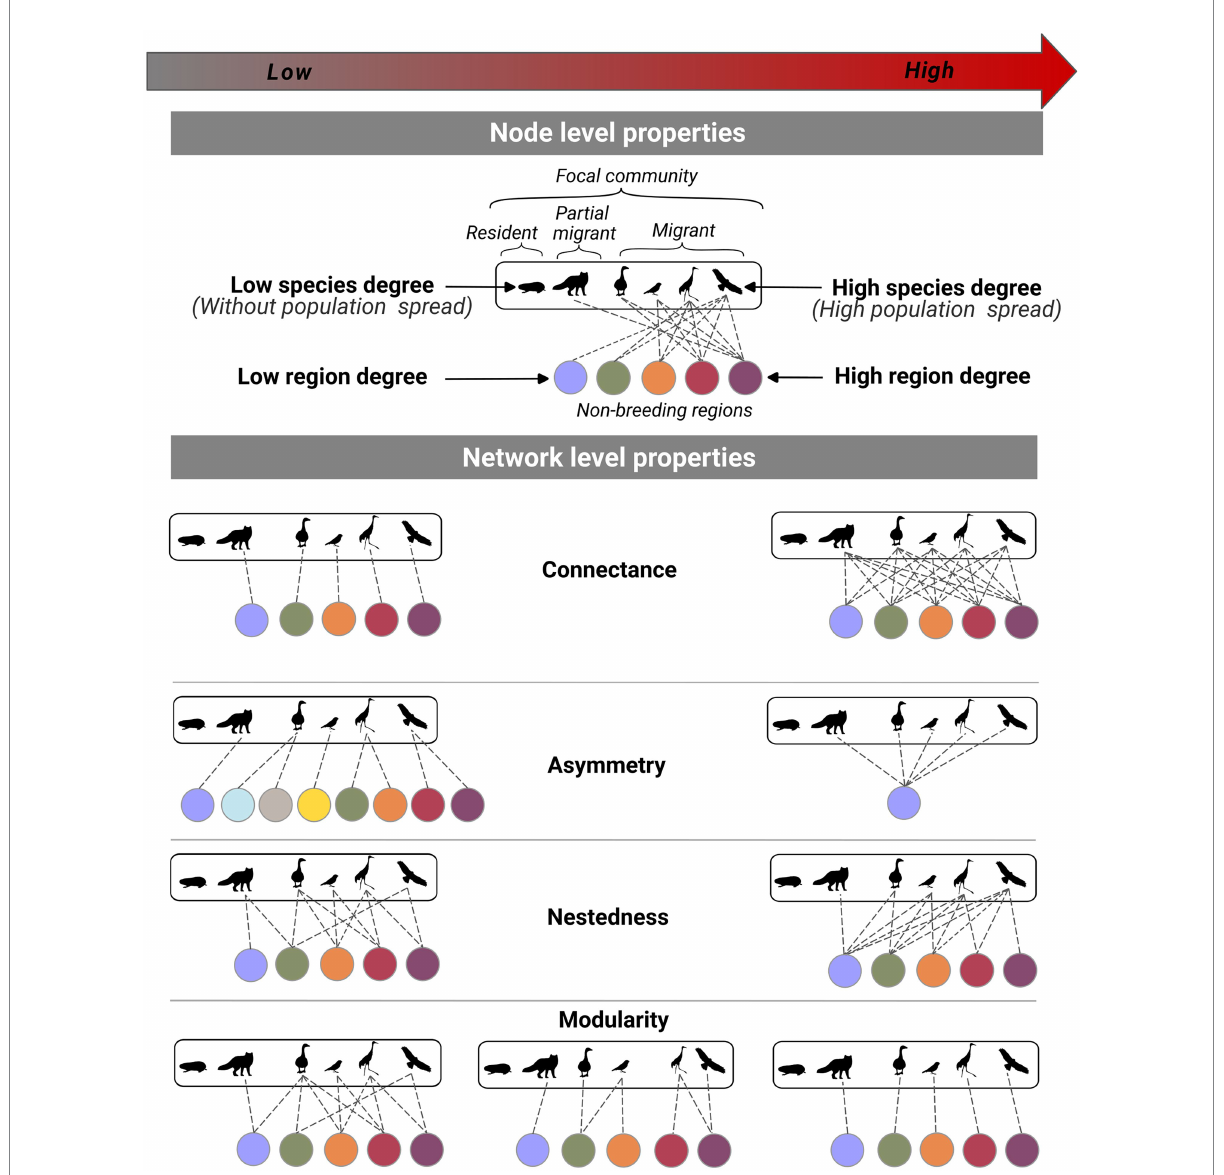
FIGURE 3 Schematic definitions and examples of low and high values of bipartite community migration network metrics. The white rectangle represents the focal community, and the colored circles represent the connected geographic regions through migrations. The dotted lines represent the movements of species between the focal community and the regions used during another period of their annual cycle. The movements of species between the focal community and the connected regions are presented as undirected to represent the use of the same pathways back and forth. Resident species are represented by the absence of